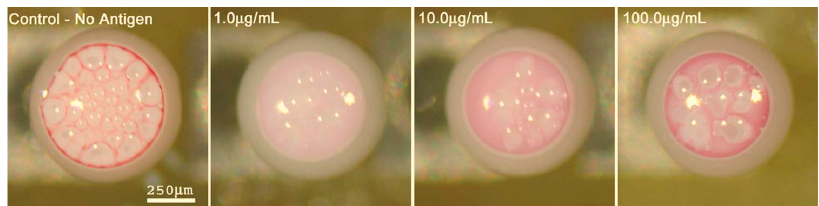
Figure 17. Resulting droplets for a 30-min incubation time and containing anti-rabbit IgG antibody functionalized gold nanoparticles at different concentrations of antigen (rabbit IgG); left to right: 0, 1.0, 10.0, 100.0 µg/mL. Reprinted with permission from [119] (p. 6). Copyright 2007 AIP Publishing.